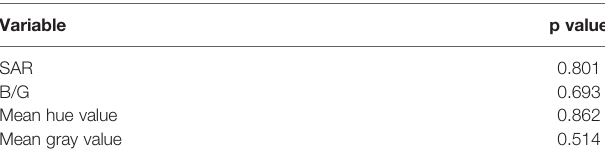
TABLE 4 | Comparison of quantitative mean values between machine learning and expert groups.